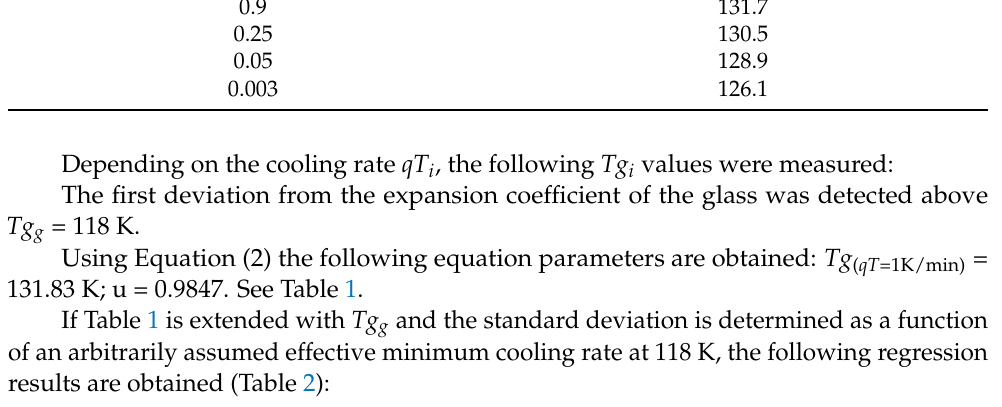
Table 2. Evolution of standard deviation for Epon 1001f-DDS with arbitrarily chosen qT min at 118 K.